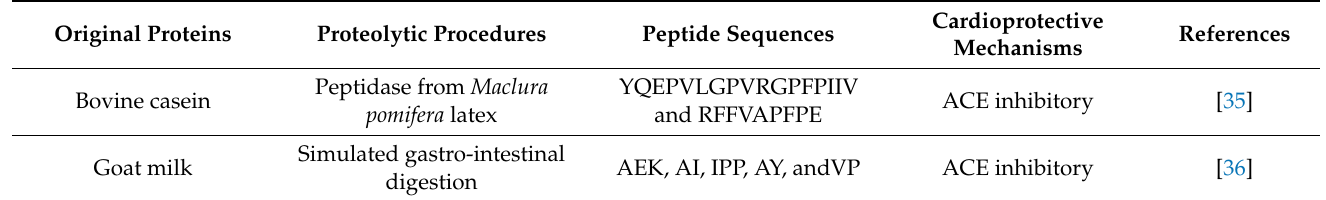
Table 1. Cardioprotective peptides derived from milk using enzymatic proteolytic procedures. Original